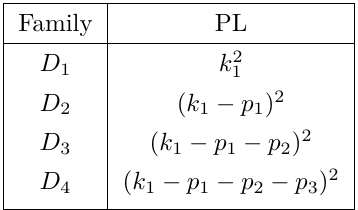
Table 1 . Planar 1-loop integral family.